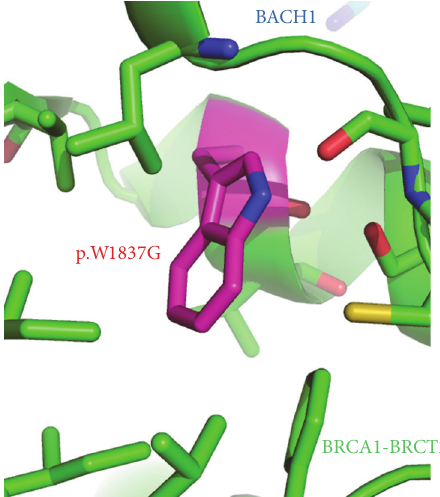
Figure 4: The structure of BRCA1 p.Trp1837 (shown in magenta with sticks) in the BRCA-BRCT domain (PDB: 1T15 [6]). Nearby hydrophobic amino acids sidechains from residue 1837 are shown as sticks. Bound BACH1 peptide is shown as teal